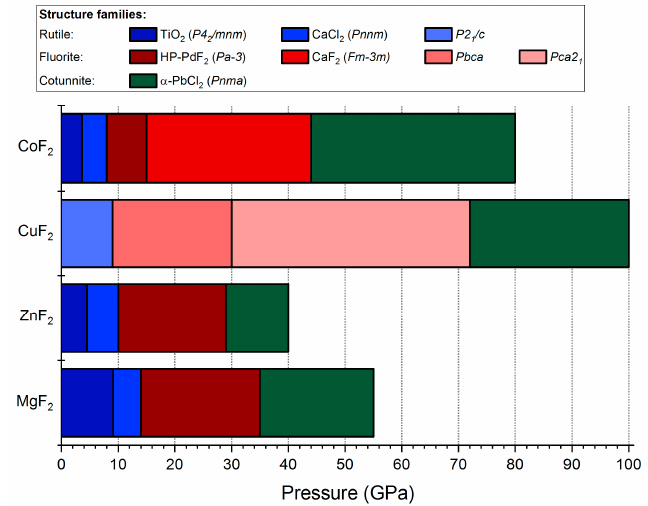
Figure 8. Bar diagram showing the pressure stability intervals of the different structural modifications of MF 2 fluorides. Experimental results for CoF 2 , ZnF 2 , and MgF 2 are taken from [23,26,31], respectively. The HP-PdF 2 to cotunnite phase transition for ZnF 2 at 29 GPa is taken from our calculations (see Figure S7 in Supplementary Materials).